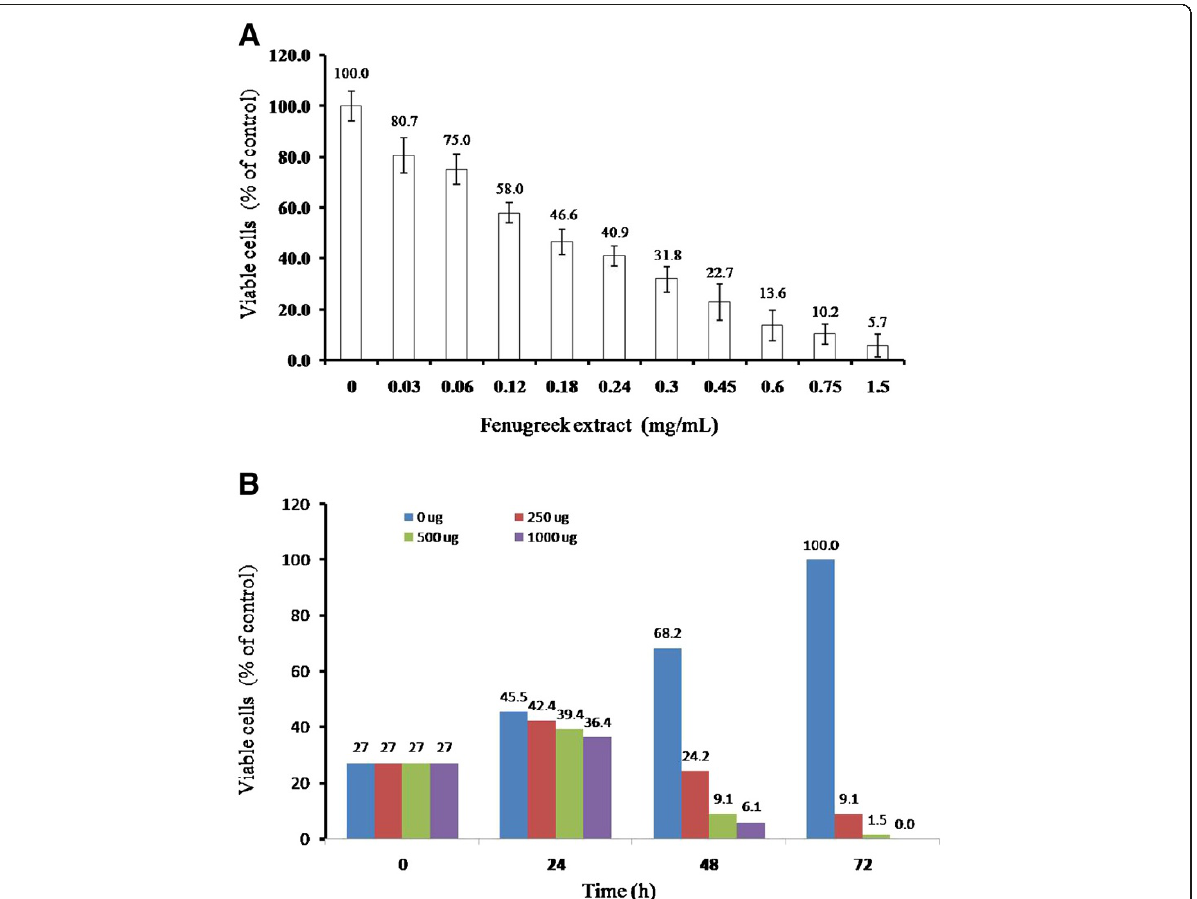
Figure 2 Fenugreek extract inhibits Jurkat cell proliferation. ( A ) Viability of Jurkat cells incubated with 30 to 1500 μ g/mL of fenugreek extract was determined after 48 hr by trypan blue assay. Death of Jurkat cells occurred at all the tested concentrations of fenugreek and followed a dose-dependent pattern. ( B ) Time-dependent increase in death of Jurkat cells upon incubation with various concentrations of